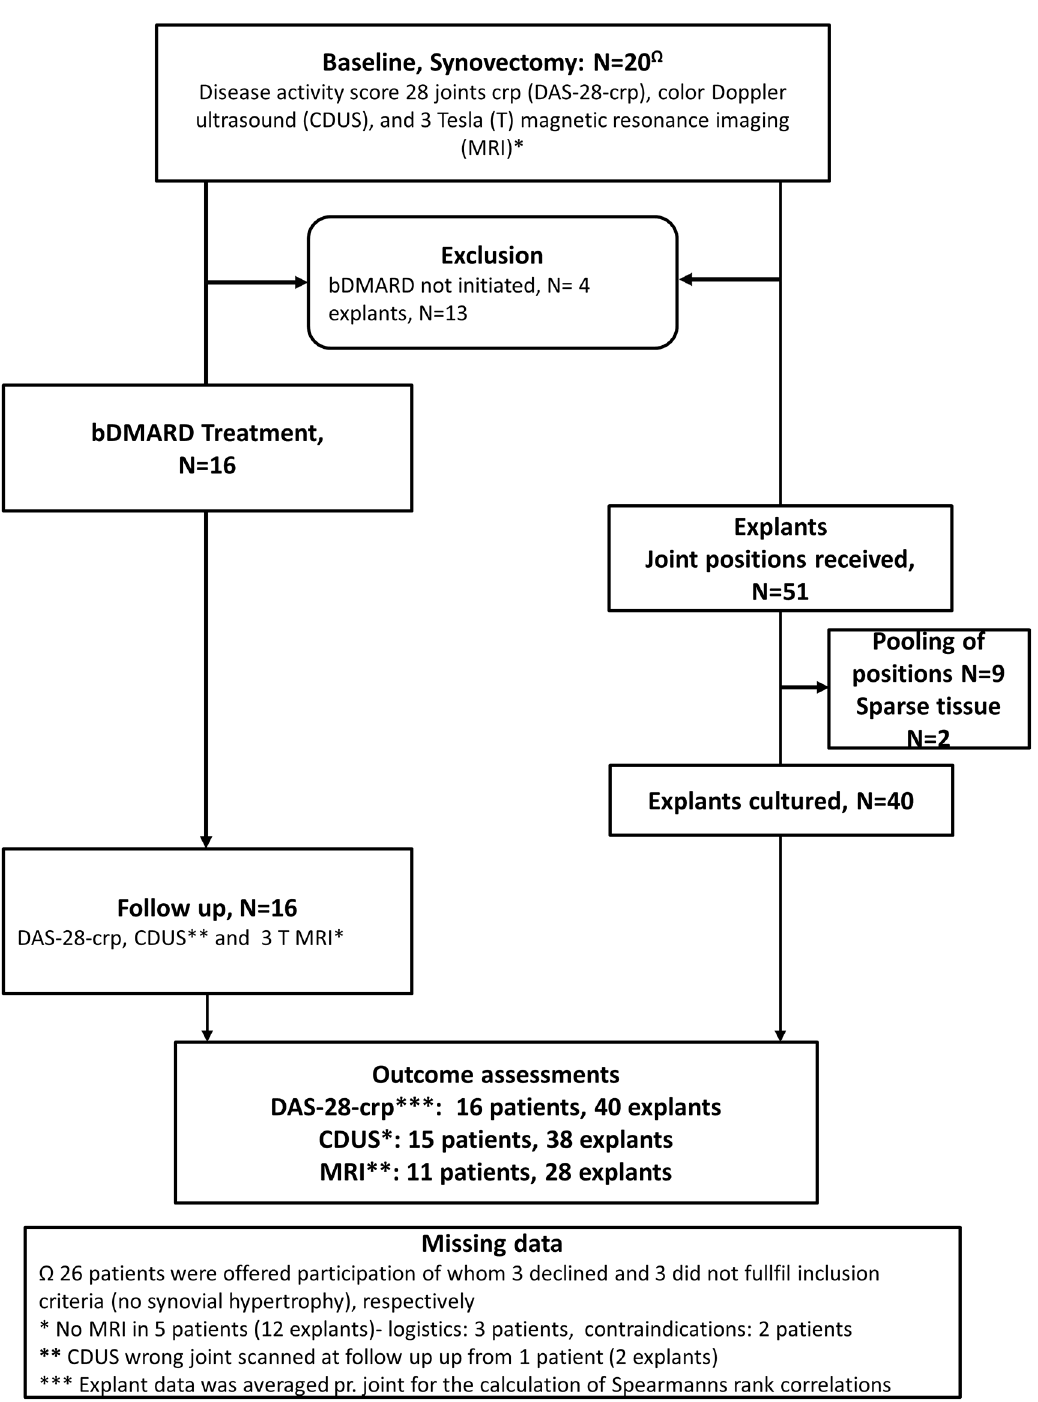
Fig 1. Flowchart outlining flow of patients, number of joints synovectomised and number of established synovial cultures. Rheumatoid arthritis patients with clinically suspected active arthritis involving the hand joints and opted for bDMARD treatment were evaluated by Doppler ultrasound for study participation. Explants were only included from patients, who were initiated in bDMARD treatment. bDMARD = biologic disease modifying anti-rheumatic treatment; CDUS = colour Doppler ultrasound; DAS-28 = Disease activity score 28 joints c-reactive protein; MRI = magnetic resonance imaging; T = Tesla; Ω = 26 patients were offered participation of whom 3 declined and 3 did not fulfil inclusion criteria (no synovial hypertrophy), respectively. (cid:3) At baseline, MRI was not performed in 5 patients due to logistics (N = 3) and contra-indications (N = 2). (cid:3)(cid:3) At follow-up, CDUS was missing in 1 patient due to logistics. (cid:3)(cid:3)(cid:3) At follow-up MRI was only performed in 11 patients due to logistics.